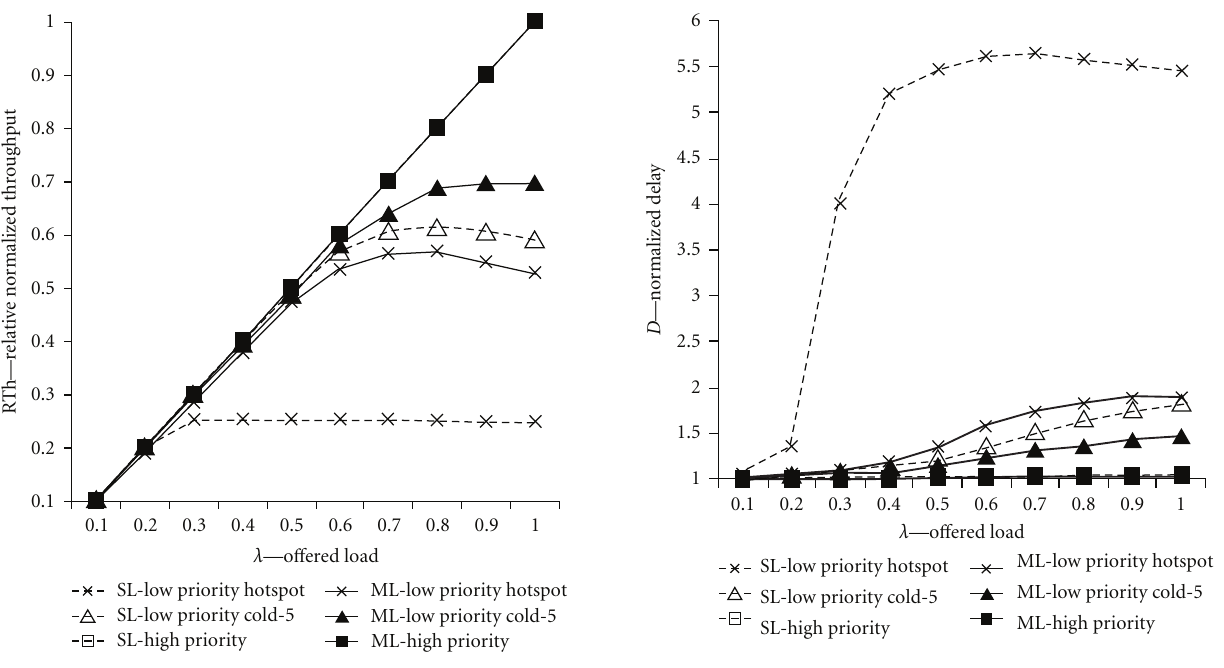
Figure 6: Relative normalized throughput of a dual-priority, double-bu ff ered, 6-stage MIN under hotspot tra ffi c at a multilayer architecture.